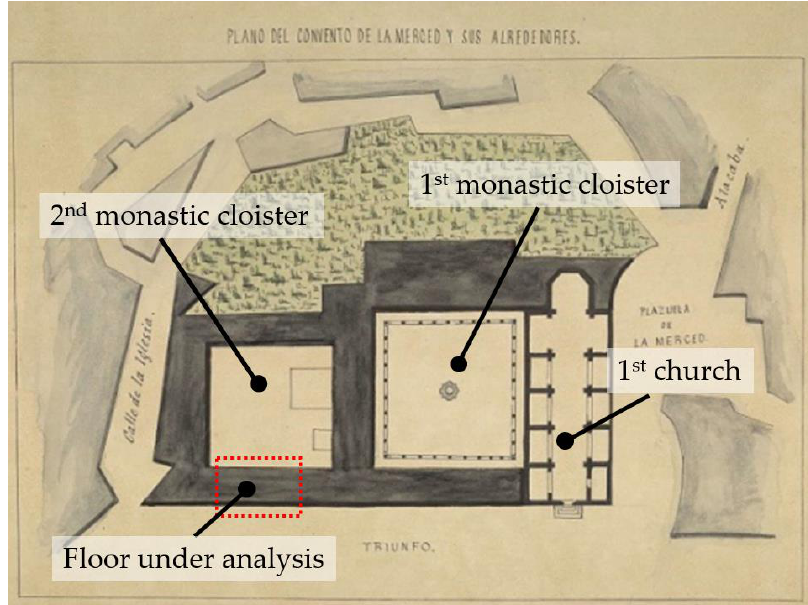
Figure 2. Location of the floor under study at the Merced Convent (plan of 1901).